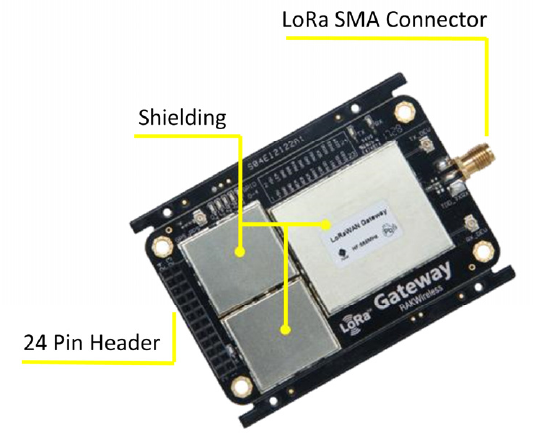
Figure 15. Raspberry Pi.